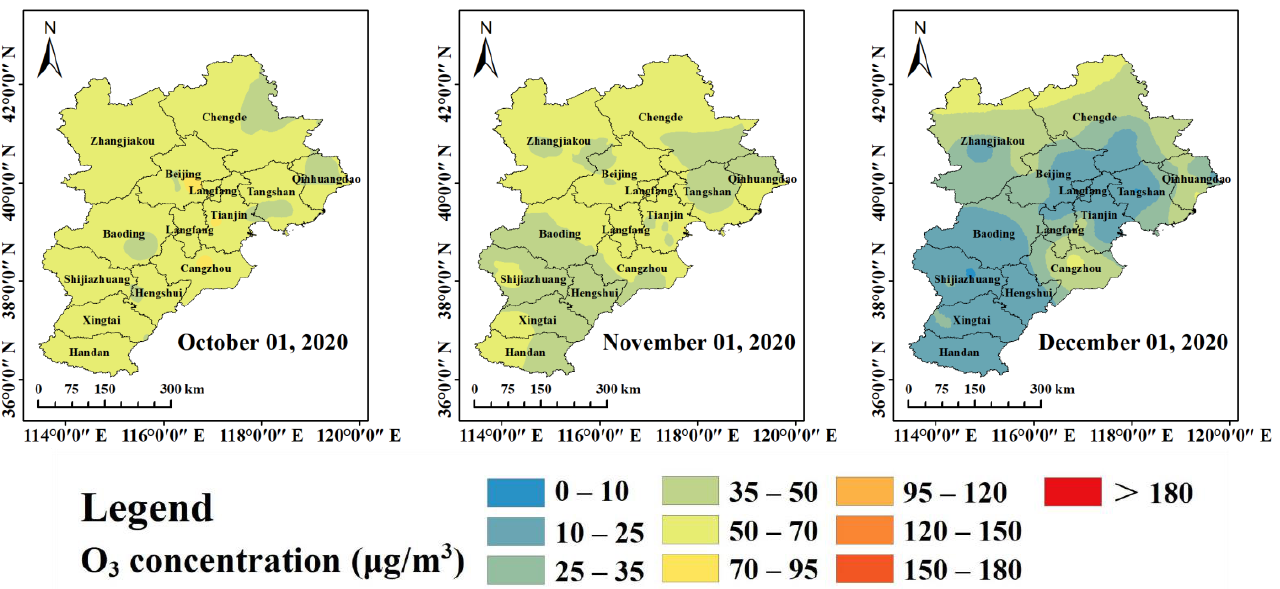
Figure 6. Spatial distribution of daily maximum 8-h average O 3 concentration on the first day of each month.